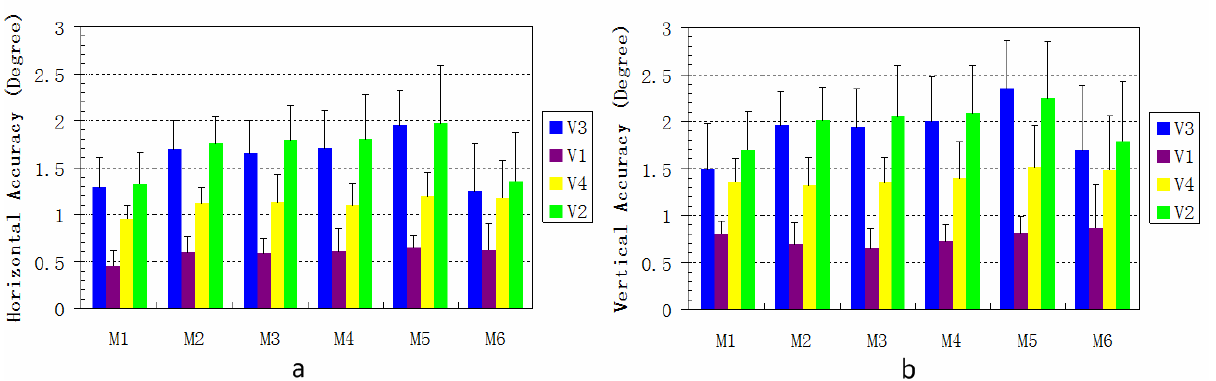
Figure 22: Histograms of mean and standard deviation of the error in degrees for methods M1~M6 corresponding to the four target points: , , ,